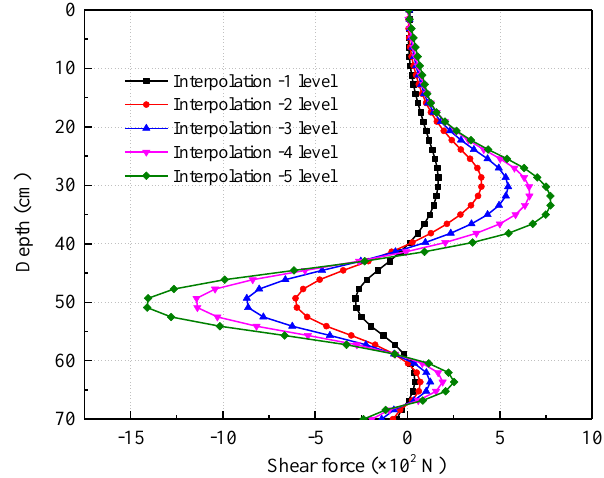
Figure 11. Shear force distribution along the length of the pile.